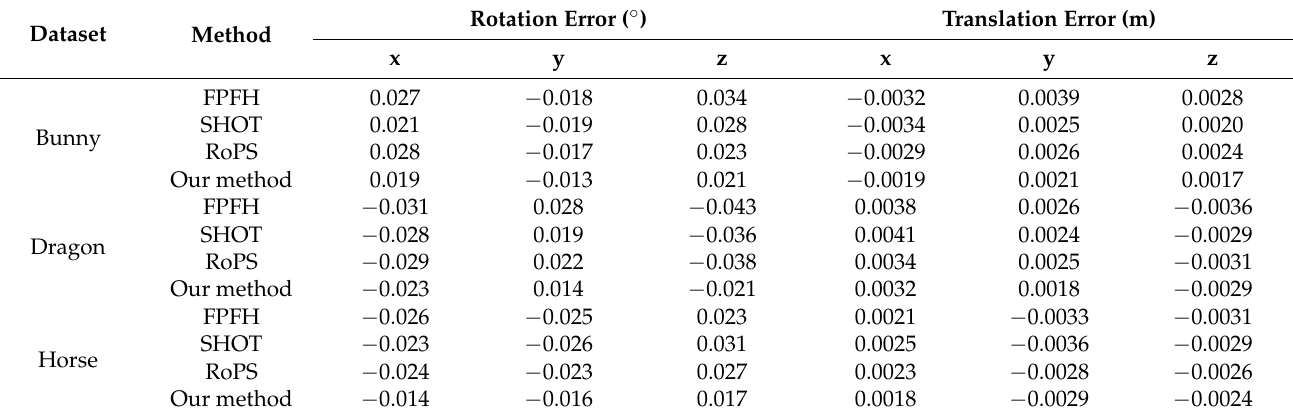
Table 2. Registration error with FPFH, SHOT, RoPS, and Our method on simulation experiment.